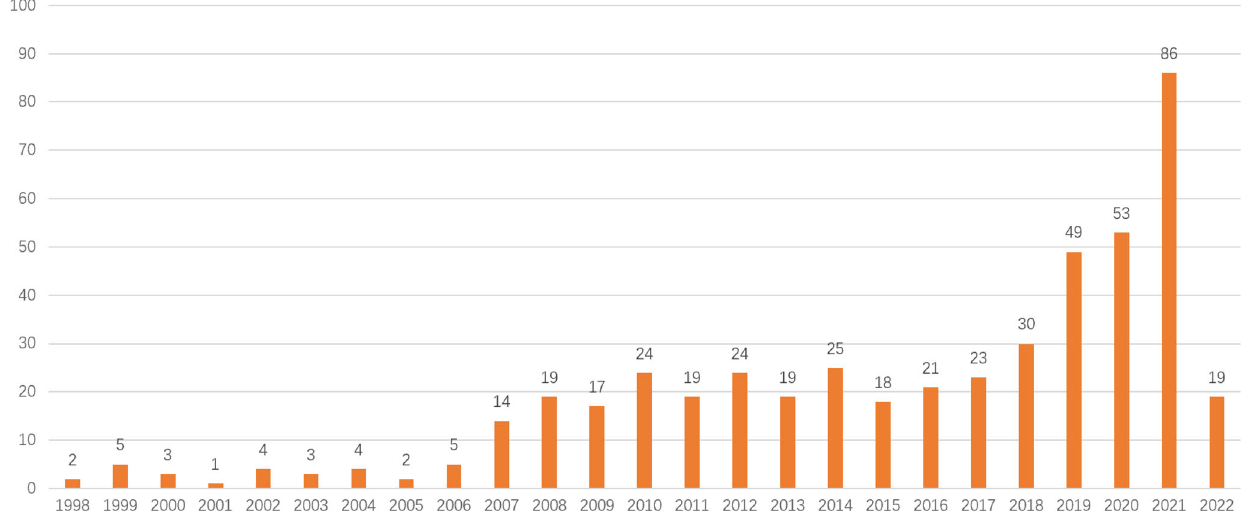
Fig. 9 Annual quantity of canal research literature in CSSCI database from the cultural economy perspective (1998 –